Question: What type of chart is this?
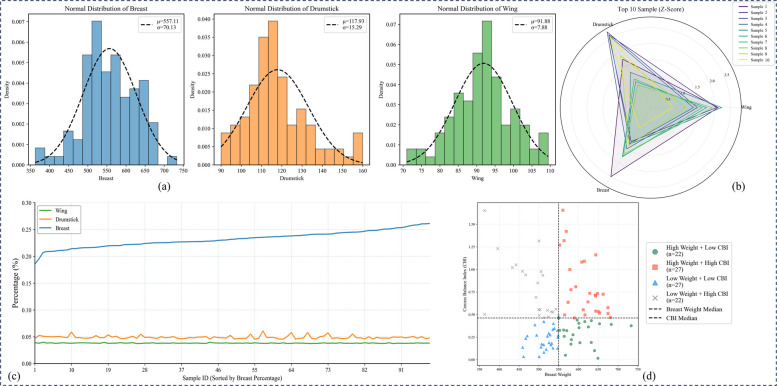
Answer: scatter